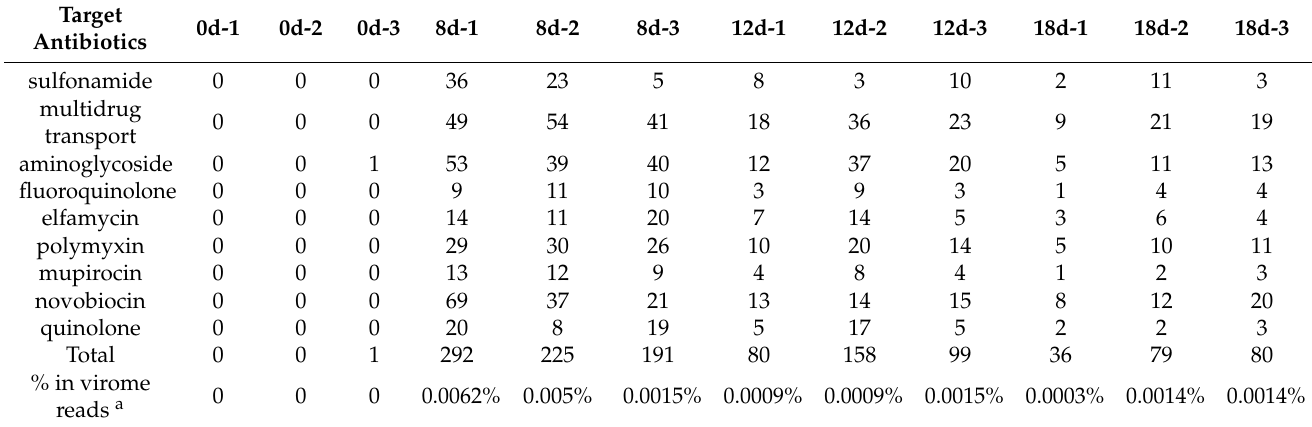
Table 3. Number of virome reads that were predicted to confer antibiotic